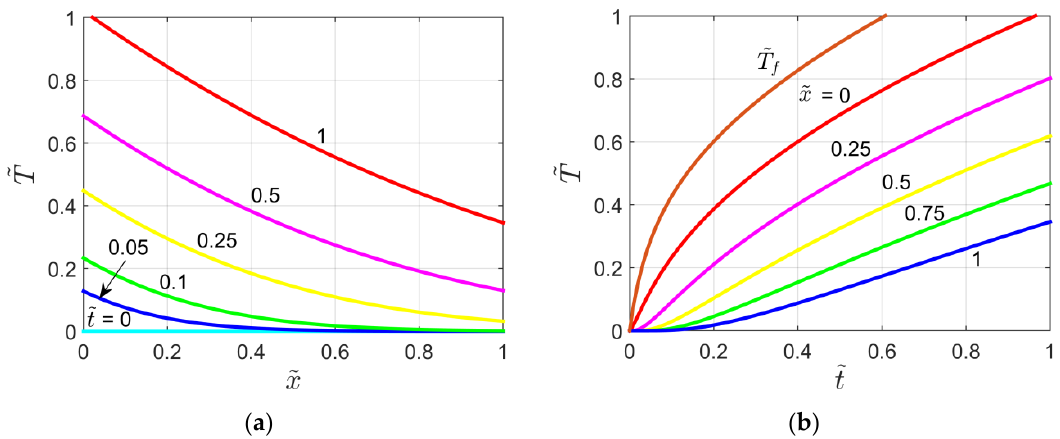
~ ~ and x as a parameter.